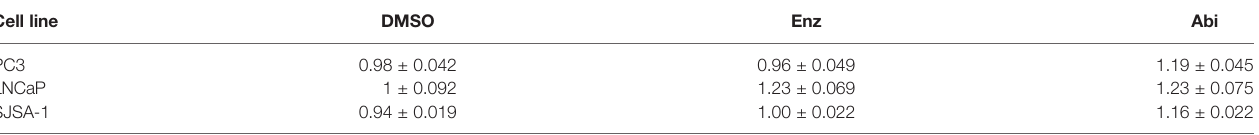
Sensitising enhancement ratio (SER) was calculated as the radiation dose needed for radiation alone divided by the dose needed for DMSO, Abiraterone or Enzalutamide at a survival fraction of